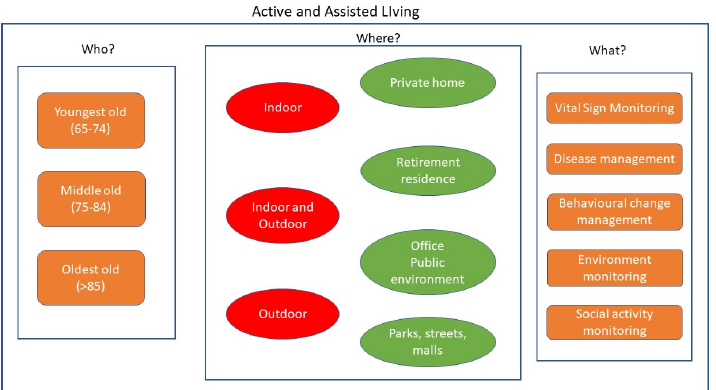
Figure 1. Fundamental aspects to be considered in the design and development of an AAL system: possible users (who?), environments (where?), and functionalities